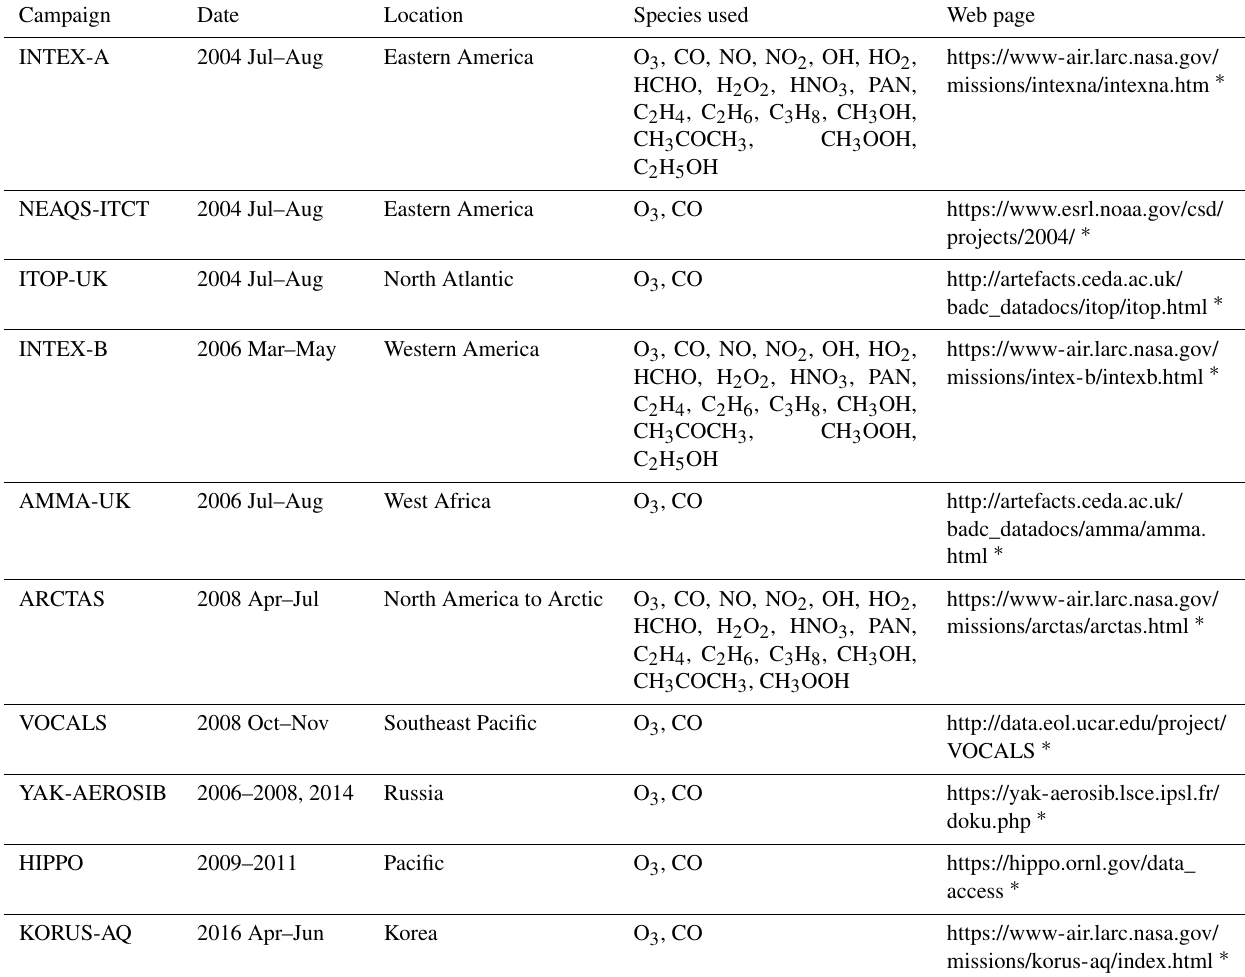
Table 3. List of aircraft campaigns used.